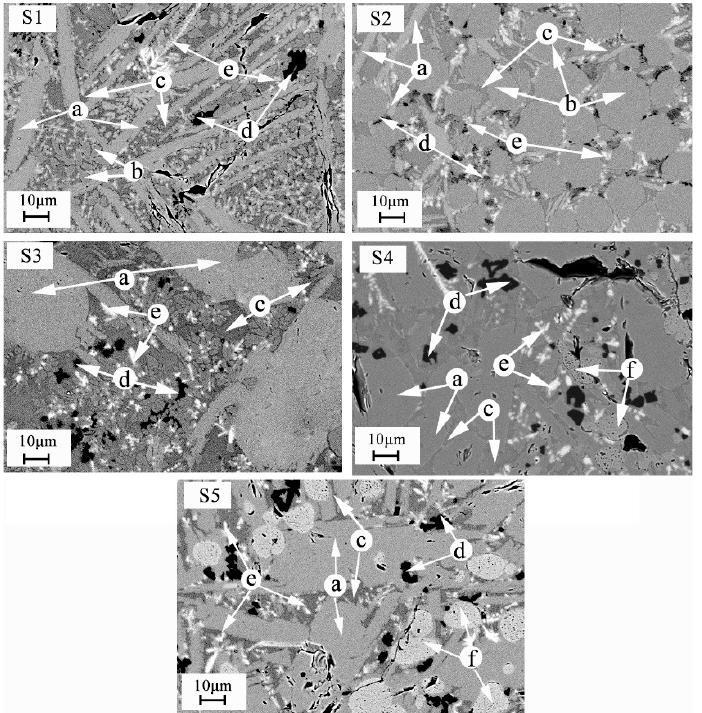
Figure 6. Micro analysis chart of slag samples with different basicity. a, C3S; b, C2S; c, matrix phase; d, MeO#2 phase; e, CaS phase; f, MeO#1 phase. S1 —with bacisity of 2.5, S2 —with bacisity of 3.0, S3 —with bacisity of 3.5, S4 —with bacisity of 4.0, S5 —with bacisity of 4.5.